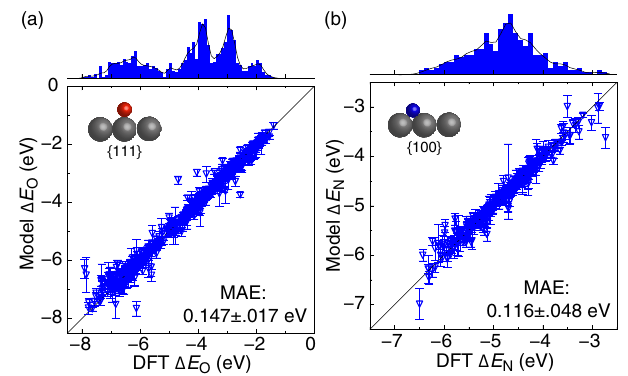
Fig. 5 TinNet models for other adsorbates/facets. DFT-calculated vs. TinNet-predicted ( a ) *O adsorption energies at the atop the site of {111}- terminated alloy surfaces and ( b ) *N adsorption energies at the hollow site of {100}-terminated alloy surfaces for all 10-fold test sets, along with a histogram of data sampling. Note : the color scheme of atoms includes red (O), blue (N), and dark gray (metal). The error bar corresponds to the standard deviation of the error estimates from 10 fi nal models.